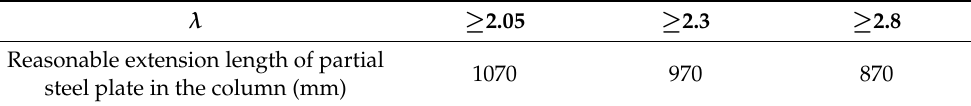
Table 6. Reasonable extension length of the partial steel plate in the column.